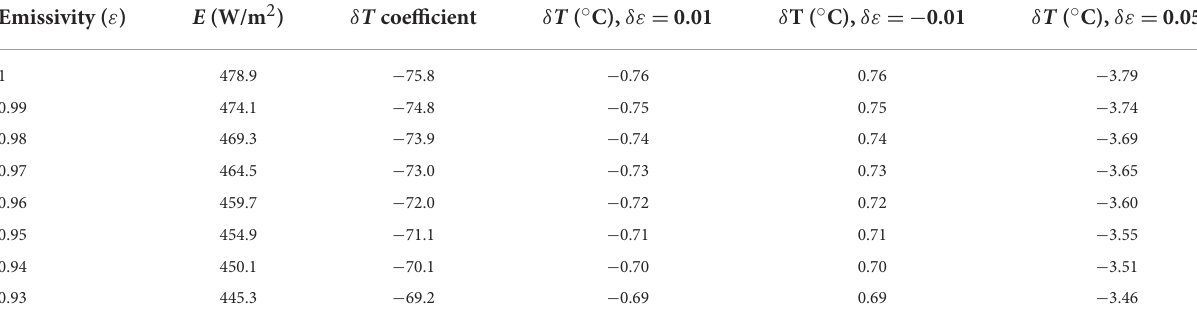
TABLE 5 The errors in resulting IR temperature if emissivity is altered for a given temperature of 30.0 ◦ C to demonstrate that change of emissivity ( ε ) 0.01 can lead to a systematic bias of 0.69 to 0.76 ◦ C where E = constant (5.67 10–8 W/ m 2 K 4 ×